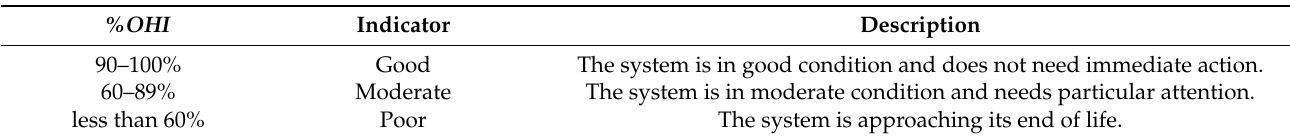
Table 9. Range of %OHI BAY for condition classification and recommended